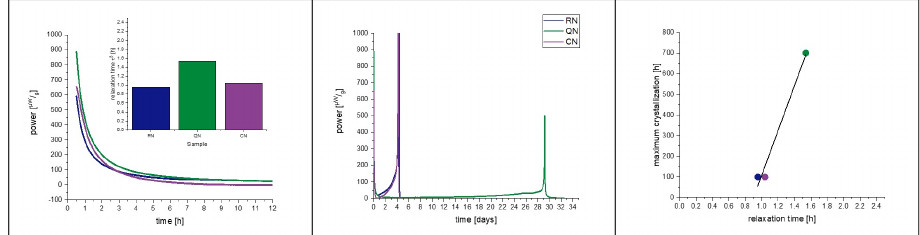
Figure 6. Moisture equalized samples from the 2 mg/mL_1.6PS_Suc formulation at 40 °C, correlation of crystallization with α-relaxation, and the effect of the freezing step. The left picture presents a zoomed in area of the IMC measurement to focus on the relaxation curves, which are converted to a τ β -value. The middle graph shows the full view of the measurement including the crystallization of the samples. On the right, the correlation of relaxation time with crystallization maximum of the IMC curves is presented. The correlation coefficient of the fit is r 2 = 0.96. Random nucleation (blue), quench cooling (green), controlled nucleation (purple).